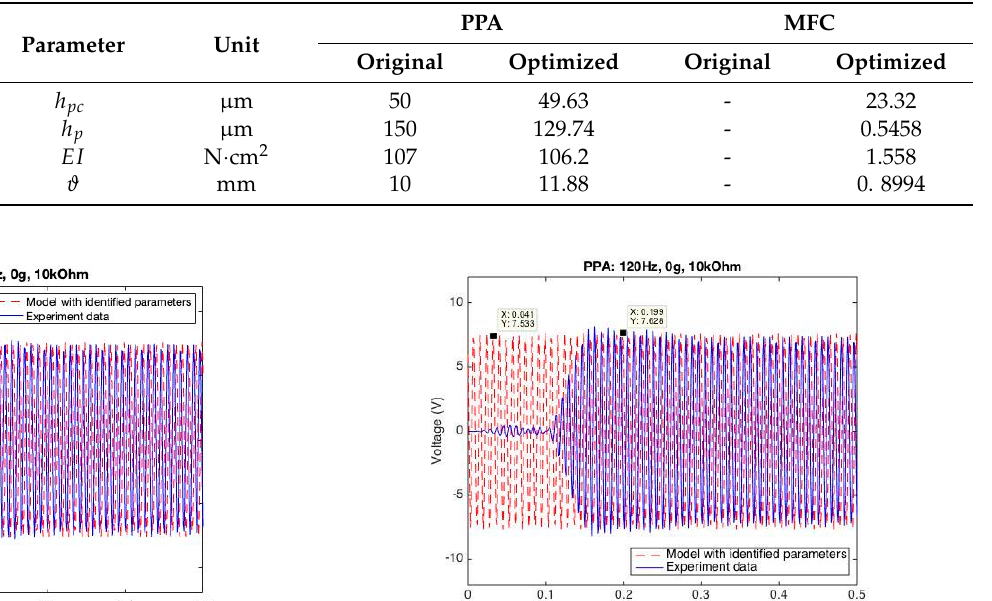
Table 2. Original and optimized parameters of PPA and MFC for the electromechanical model.